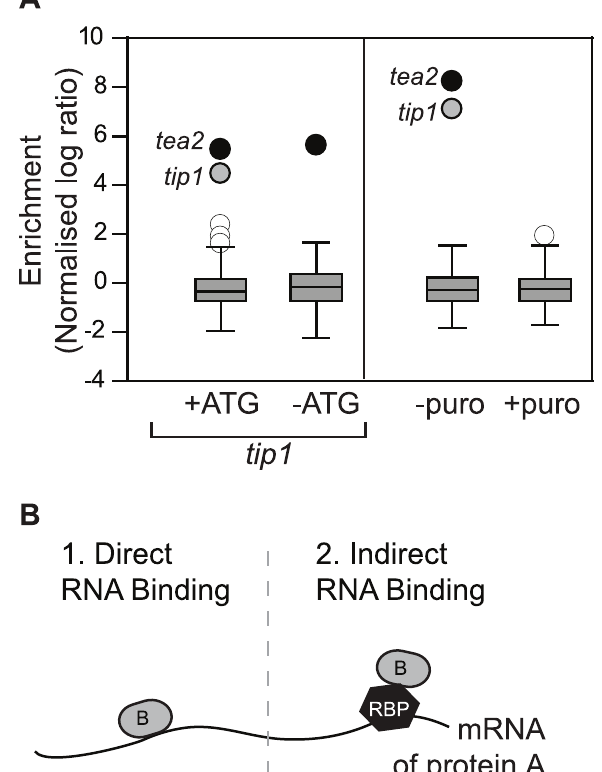
Figure 1. Cotranslational assembly of the Tea2p-Tip1p com- plex. (A) RIp-chip experiments with Tea2p. The y axis shows the log 10 enrichment ratios in Tea2p RIp-chip experiments, standardised to make the mean and standard deviation equal to 0 and 1, respectively. The box plots show the distribution of enrichments, with the box showing the lower and upper quartiles, the whiskers representing data within the upper/lower quartile plus/minus 1.5-fold the interquartile range, and other data points displayed as circles. White circles represent mRNAs not considered significant (either because they are common contaminants in multiple RIp-chip experiments, or because they were not reproducibly enriched in independent replicas of the experiment), black circles correspond to mRNAs encoding the bait, and grey circles are used for mRNAs specifically associated with the bait protein. Left: Tea2p copurifies with wild type tip1 ( + ATG), but not with tip1 that cannot be translated ( 2 ATG). Right: The interaction between Tea2p and the tip1 and tea2 mRNAs is lost upon treatment of the cells with puromycin. (B) Three models to explain the association between Tea2p and the tip1 mRNA (see text for details). (C) Design of the 2 ATG experiment coupled to RIp-chip analysis. A single nucleotide mutation to the start codon prevents the translation of tip1 . If the association between Tea2p and tip1 is cotranslational, lack of Tip1p should abolish their